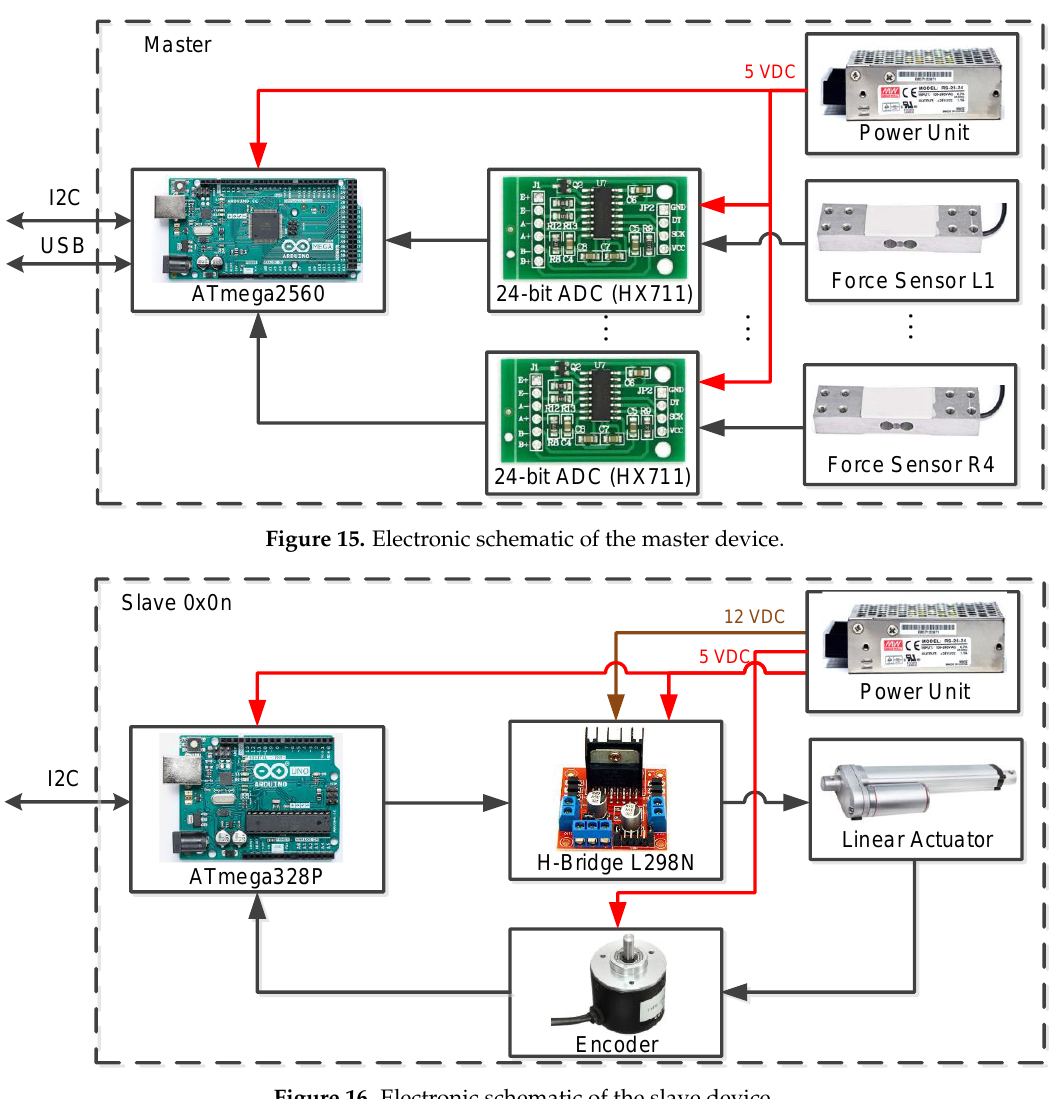
Figure 16. Electronic schematic of the slave